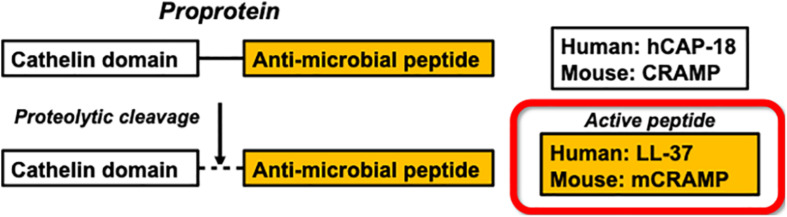
Enzymatic processing of the human antimicrobial peptide LL-37 and the mouse ortholog mCRAMP.